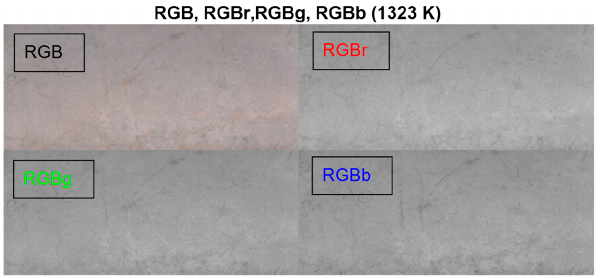
Figure 9. Surface image of blade No. 2 (1323 K). Adapted with permission from Ref. [8]. 2022, AFIT.)